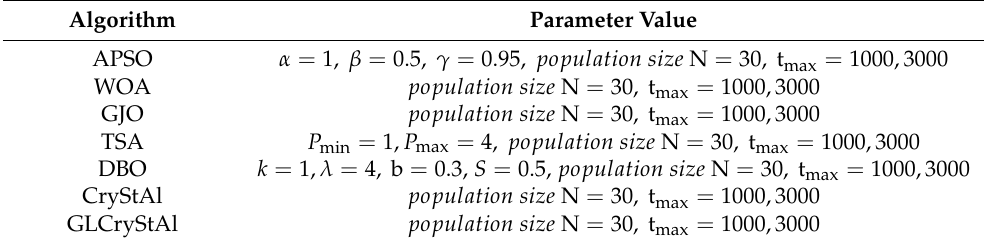
Table 2. Parameter values of the